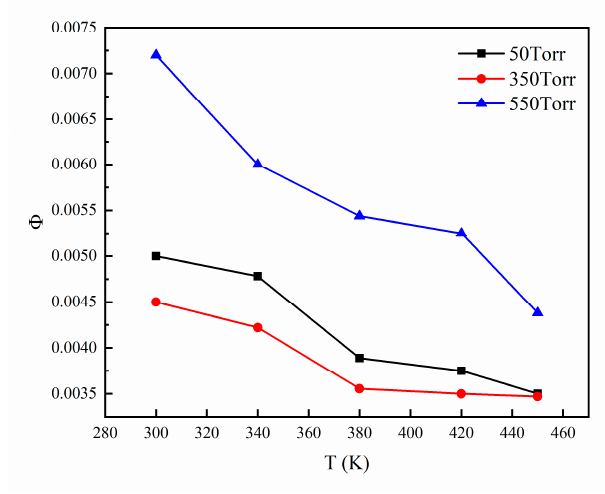
Figure 14. Lean ignition limit under different total inlet temperature and ∆ p conditions (Ma = 0.1).